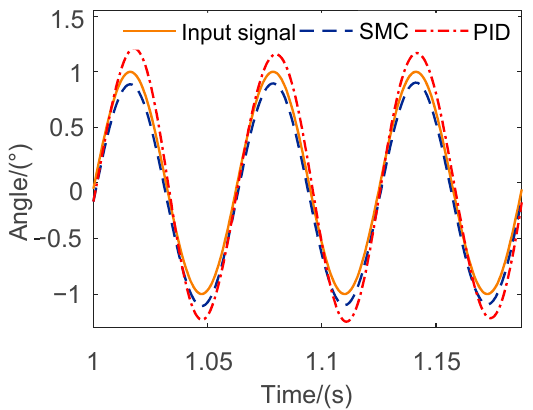
Figure 10. Dynamic response of the controller with sinusoidal excitation at 15 Hz and 1 ◦ .